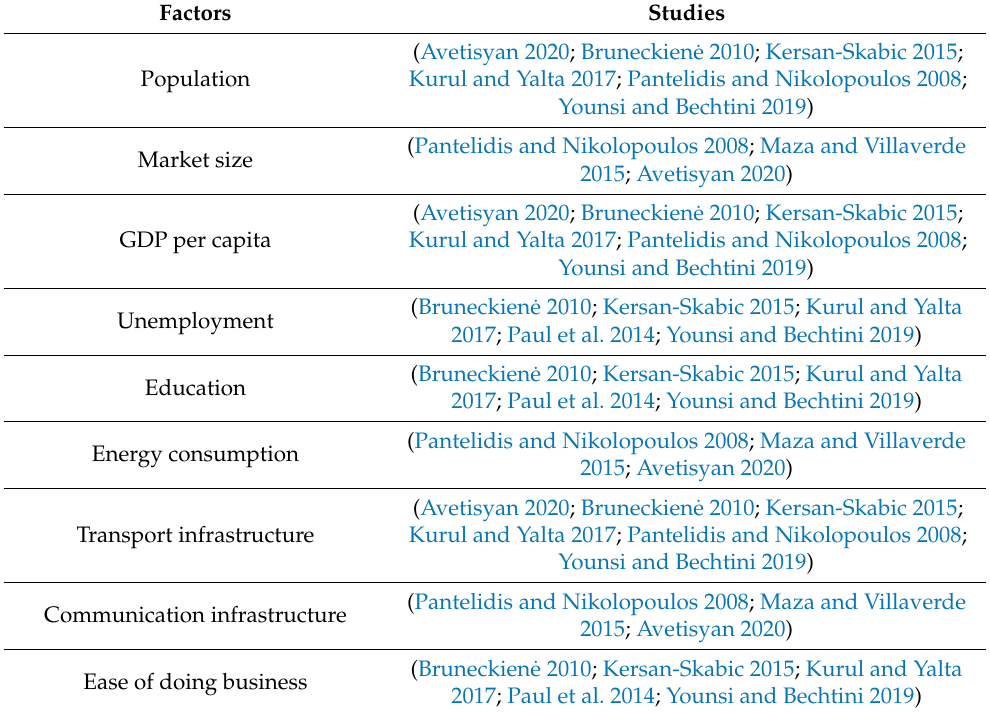
Table 2. The factors affecting